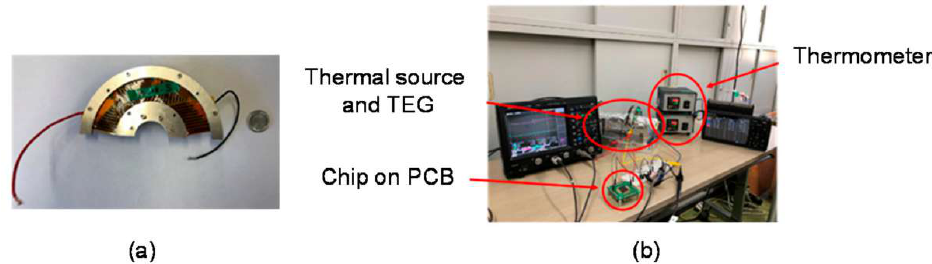
Figure 10. The TEG module ( a ) and experimental setup with the TEG ( b ).